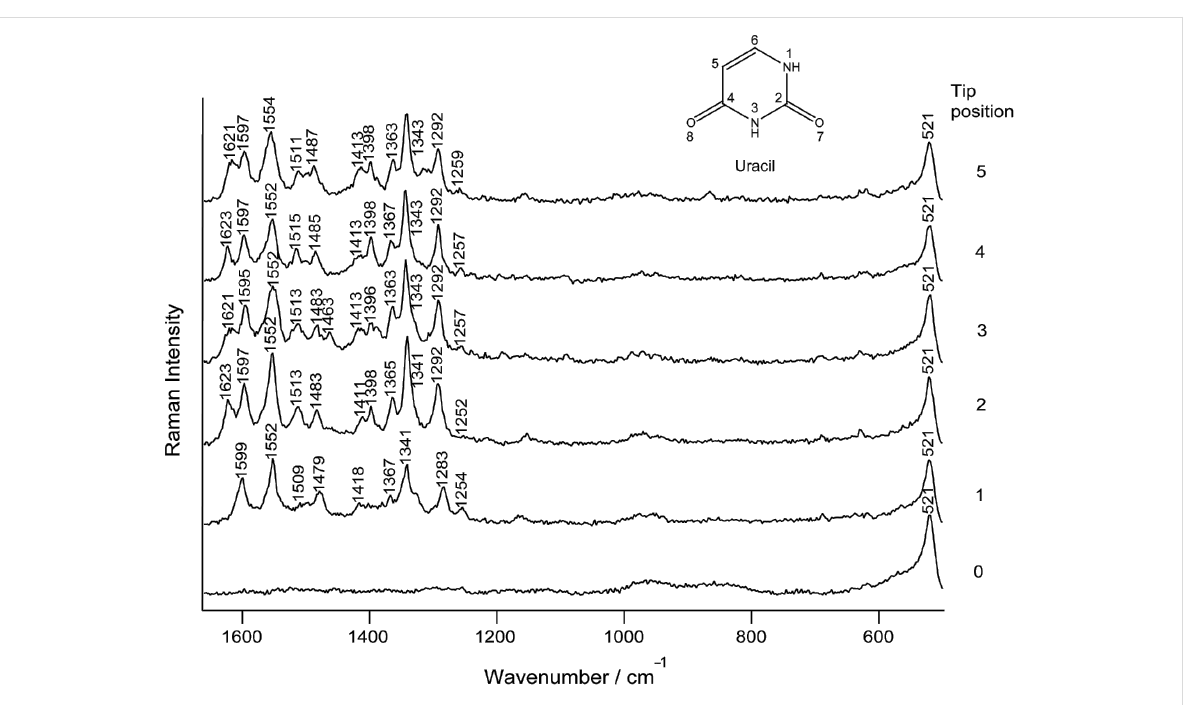
Figure 4: TERS spectra of the uracil homopolymer, measured at the positions indicated in Figure